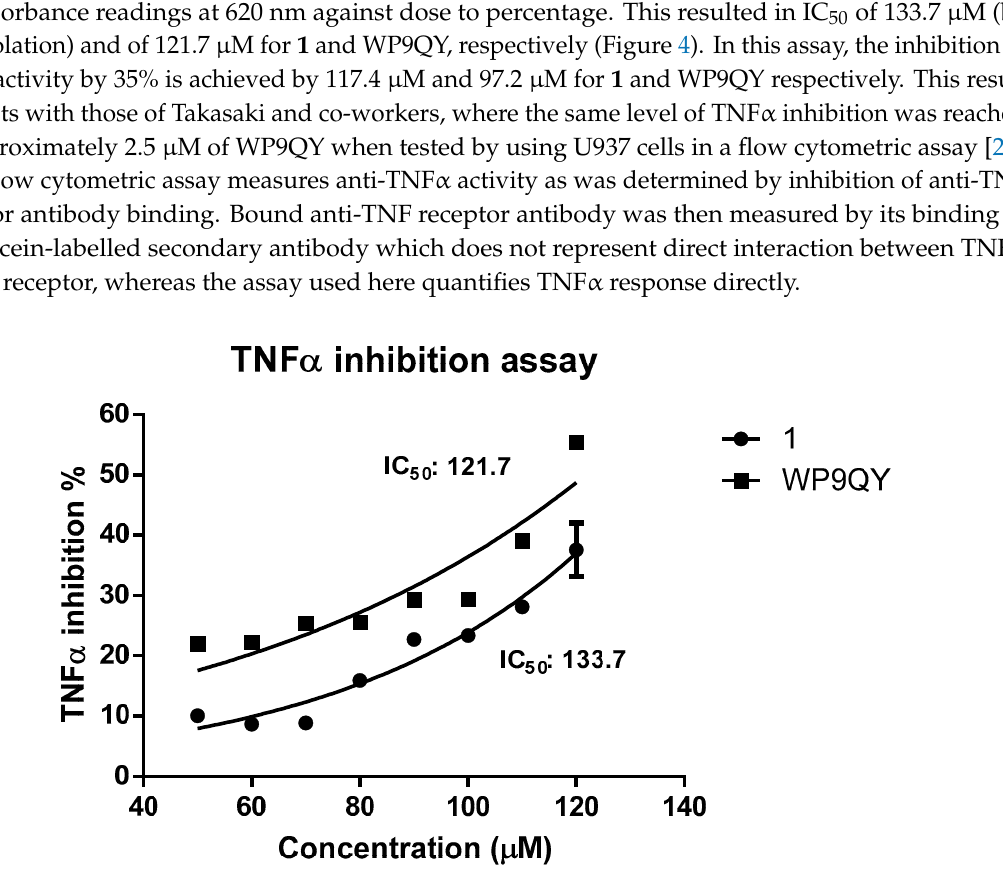
Figure 4. Dose-response curve of anti-TNF α activities of 1 and WP9QY. This assay was performed with one duplicate, and the error bar represent standard error. Non-linear regression was used to fit the curve to the measured data points. While measurements for 1 are well-fit, the WP9QY data shows slight deviations from those expected, this may be due to a different mode of action.